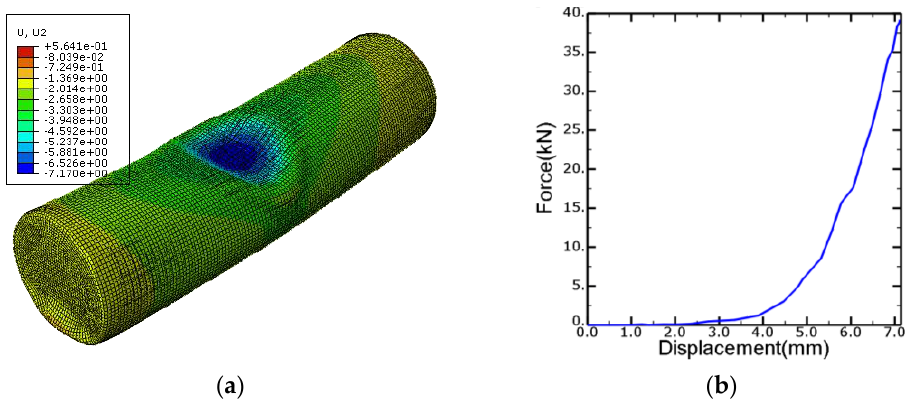
Figure 4. ( a ) Deformed shape at the maximum deformation. ( b ) Force vs. displacement curve showing change of compressive stiffness values. Some like −8.099e -02 means −8.099 × 10 − 2 .